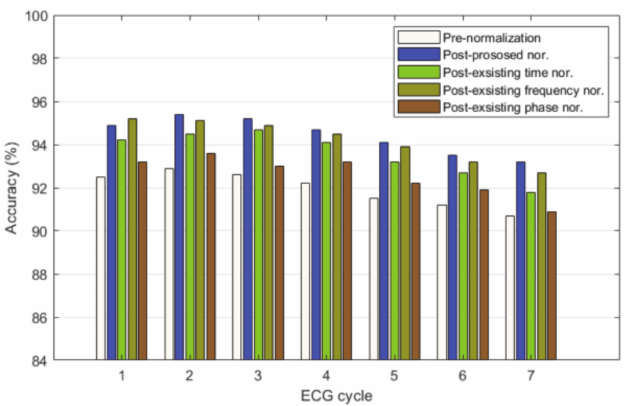
Figure 14. Comparison of identification performance using existing and proposed